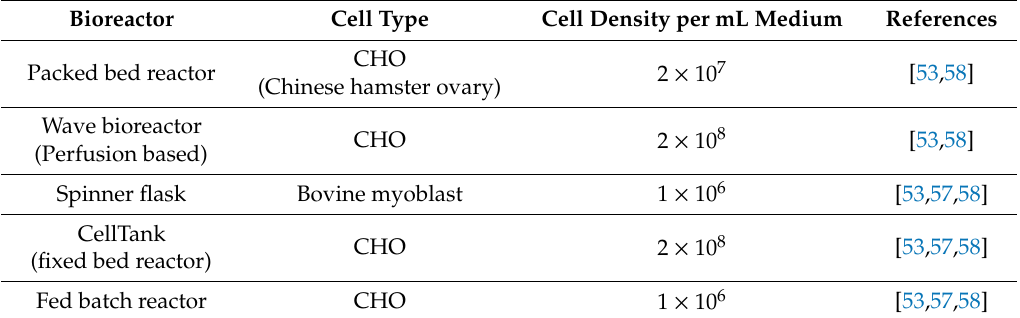
Table 3. Some examples of bioreactors based muscle cell culture (adapted from Moritz et al.